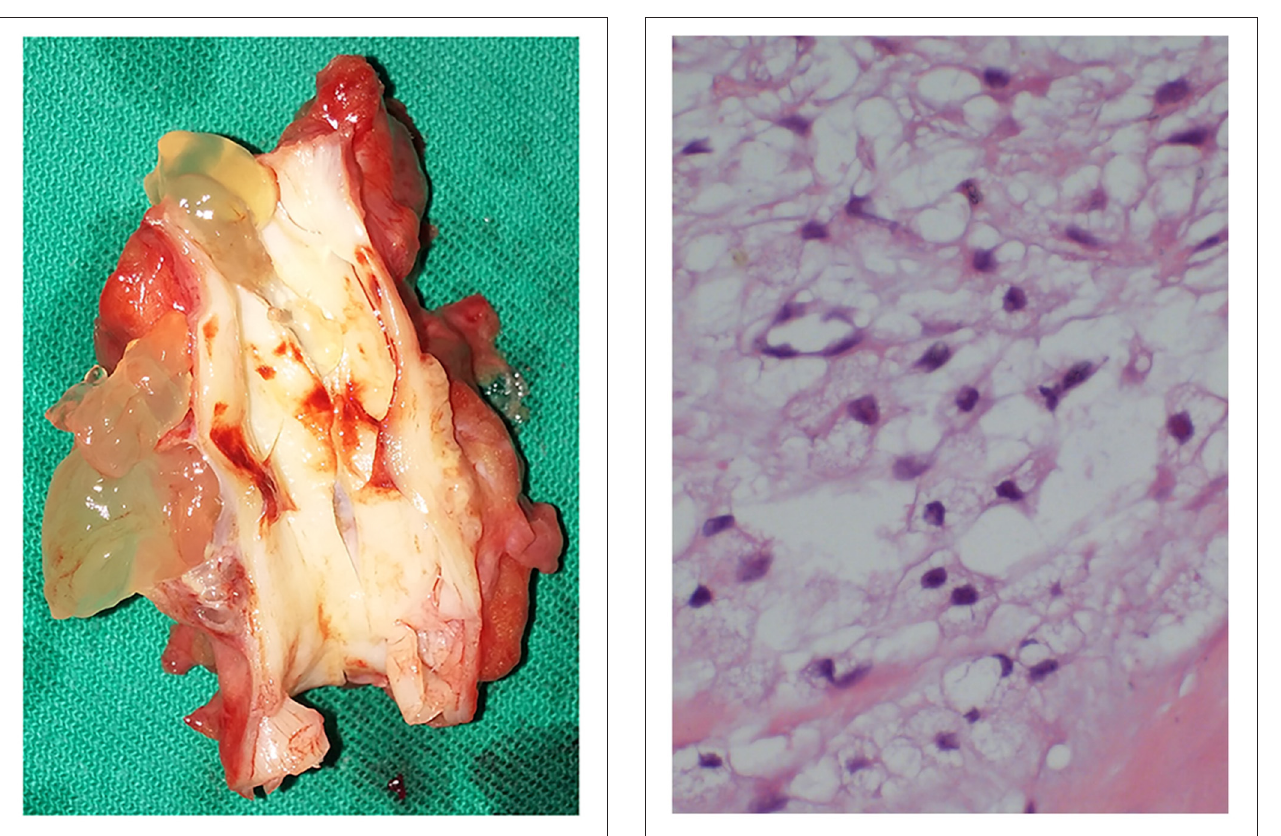
FIGURE 3 | Adventitial-cyst specimen. FIGURE 4 | Histopathological examination of the common femoral artery (stained with hematoxylin and eosin) showed mucus degeneration, mucus retention, and cystic changes in the common femoral artery